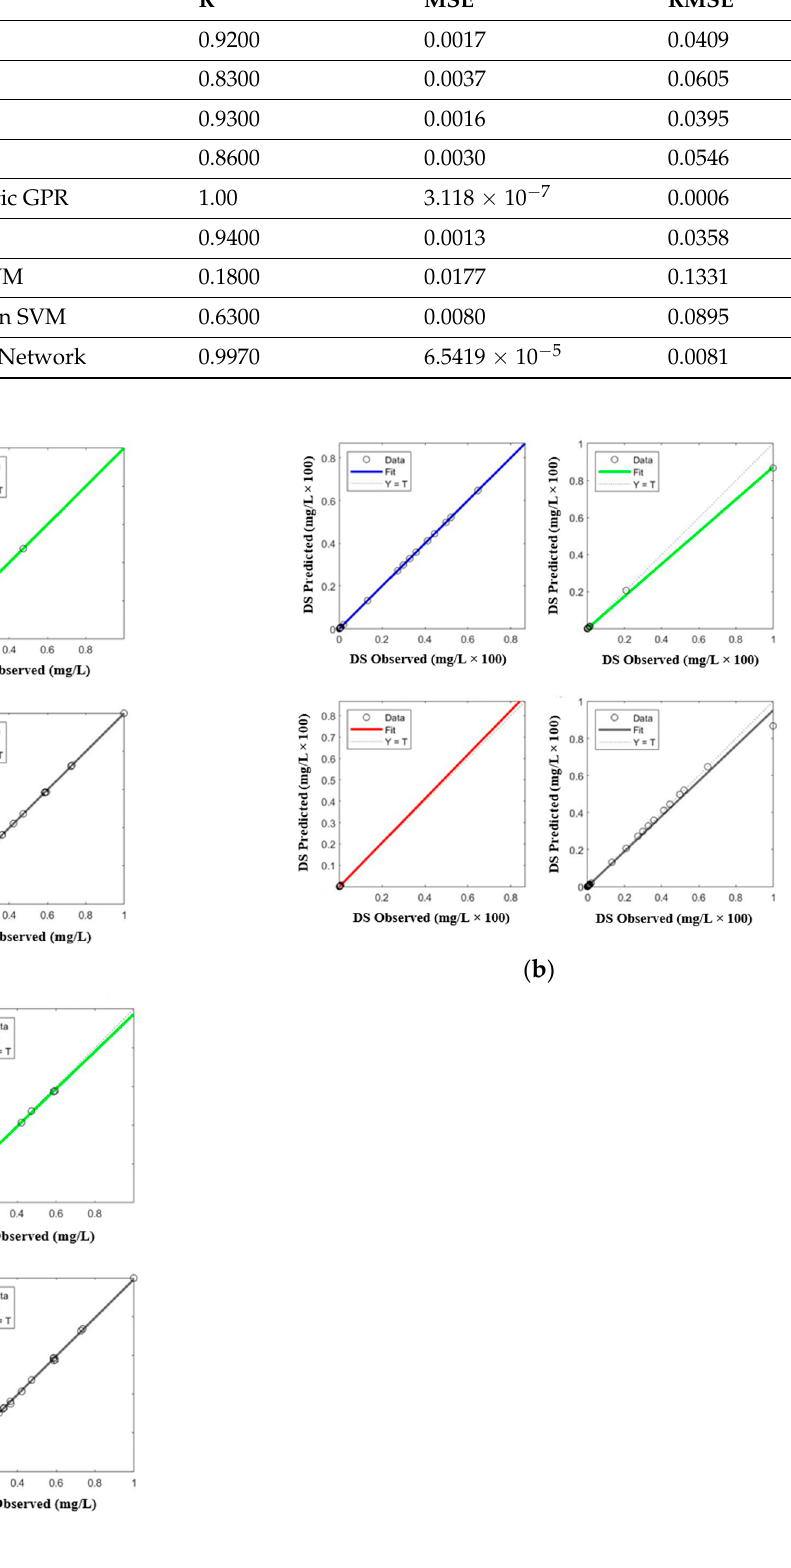
Figure 3. The scatter plots of ANN models in predicting ( a ) TSS, ( b ) DS and ( c ) TS. Comparisons between Regression, SVM, and ANN models Based on Tables 3 and 4, ANN model has proven to be good in predicting TS, TSS, and DS with high degree of accuracy and robustness by obtaining high values of R 2 and lower values of RMSE and MSE. Moreover, rational quadratic GPR model also exhibited similar performance, however, over-fitting might occurred during modeling since the model obtained R 2 = 1.00 for overall datasets in all three predictions. A research conducted by Zhou et al. [17] also used GPR models to predict water quality parameters, but it does not achieved results that is too perfect like the one obtained in this study. Similarly, the SVM models also did not performed well as it always exhibited poor performances. Past researches done by Najah et al. [16] and also several studies performed by [30] and [31] have proven that SVM model able to predict many kinds of water quality parameters. Contrary, the developed SVM models in this study did not achieved the same outcome. The reason was probably that SVM model is much suitable to be used to identify subtle patterns in a complex datasets [32] or it is because SVM model performed too well in a small datasets. Therefore, it can be concluded that ANN models were stable in forecasting